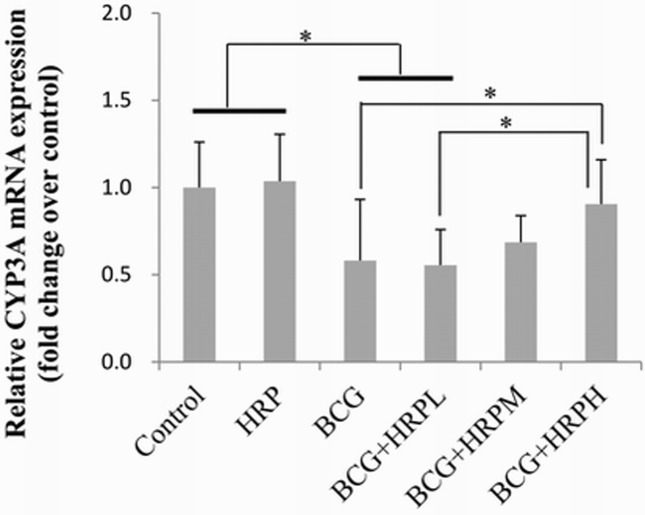
Effect of HRP on CYP3A mRNA expression according to GAPDH levels in rat livers of immune-mediated liver injury.Rats were treated with BCG (125 mg kg-1, intravenously, once for 2 wks) or BCG + HRP (50, 100, or 200 mg•kg-1•d-1, oral administration for 13d). The mRNA expression of CYP3A was measured by real-time PCR. Each bar represents the mean ± SD from three independent experiments (n = 10/group). Asterisks stars above bars indicate differences between groups. The significance of the data was determined by one-way analysis of variance (ANOVA) followed by Tukey’s test.